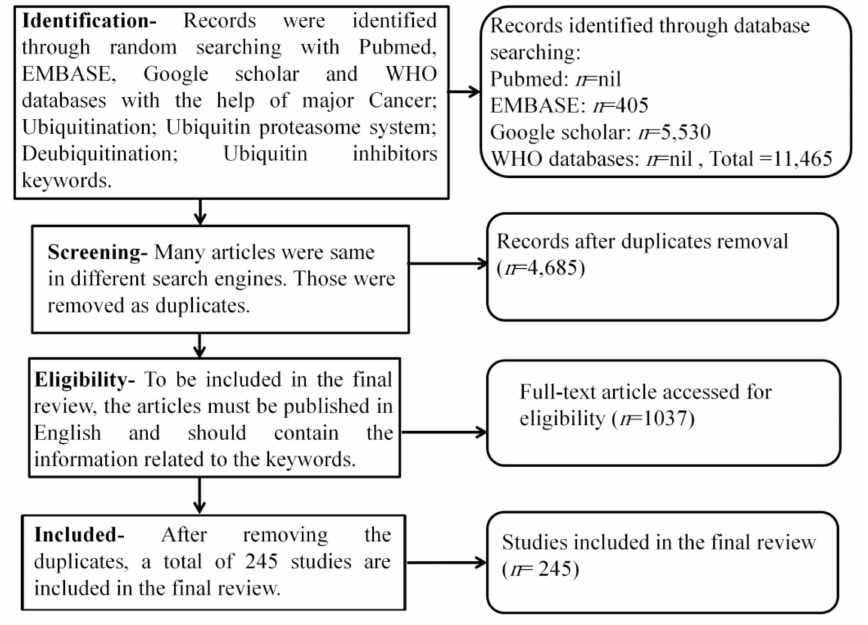
Figure 2. Flowchart of